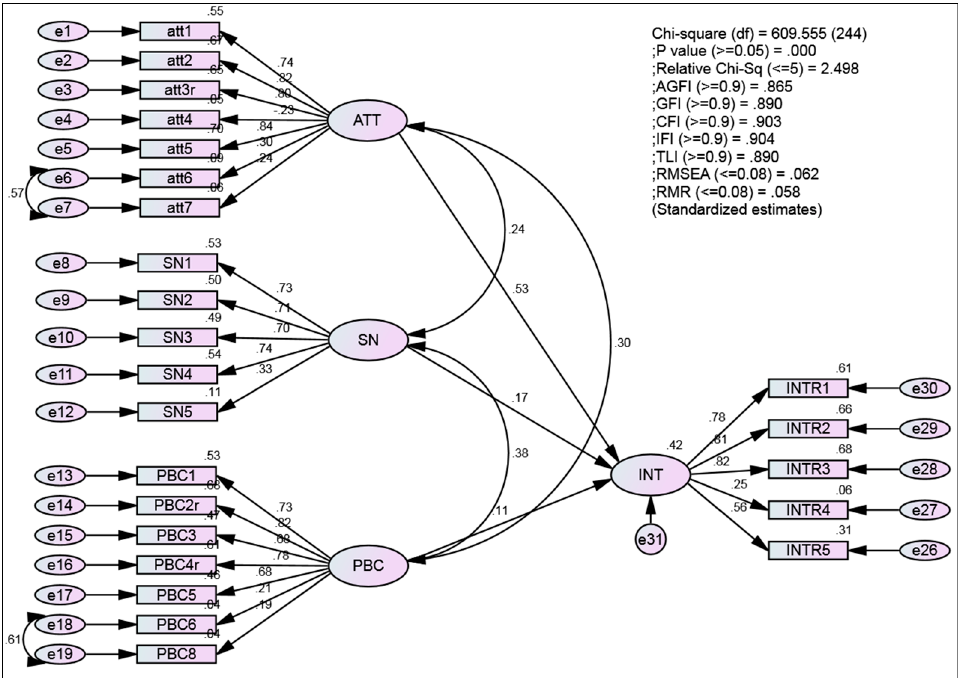
Figure 5. A Structural model explaining the level of prediction of recycling intention by TPB variables.